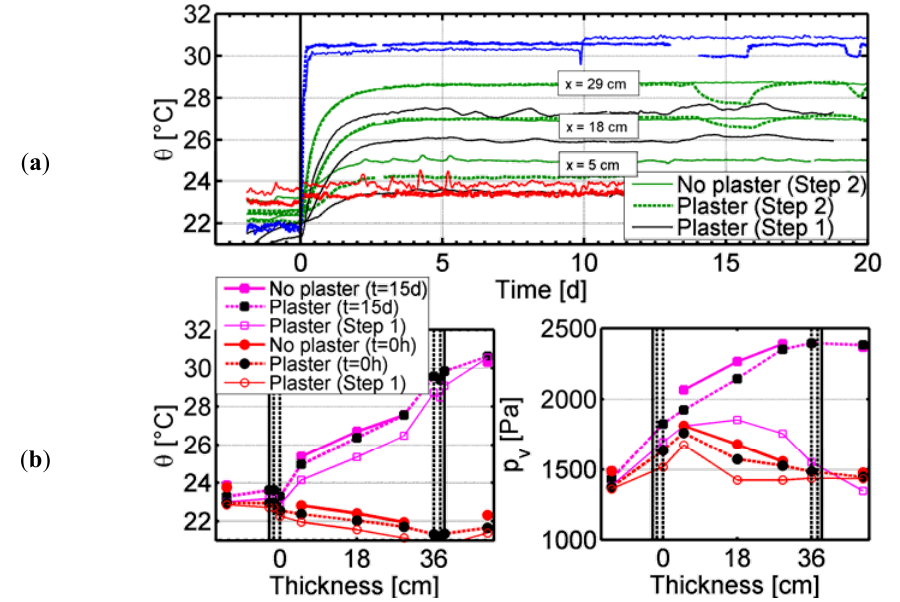
Figure 15. Comparison of experimental results for uncoated (solid lines) and coated (dashed lines) wall subjected to temperature and vapor pressure gradient. Time response in θ is shown on the top graph ( a ); and spatial response in θ and p shown on the bottom graph ( b